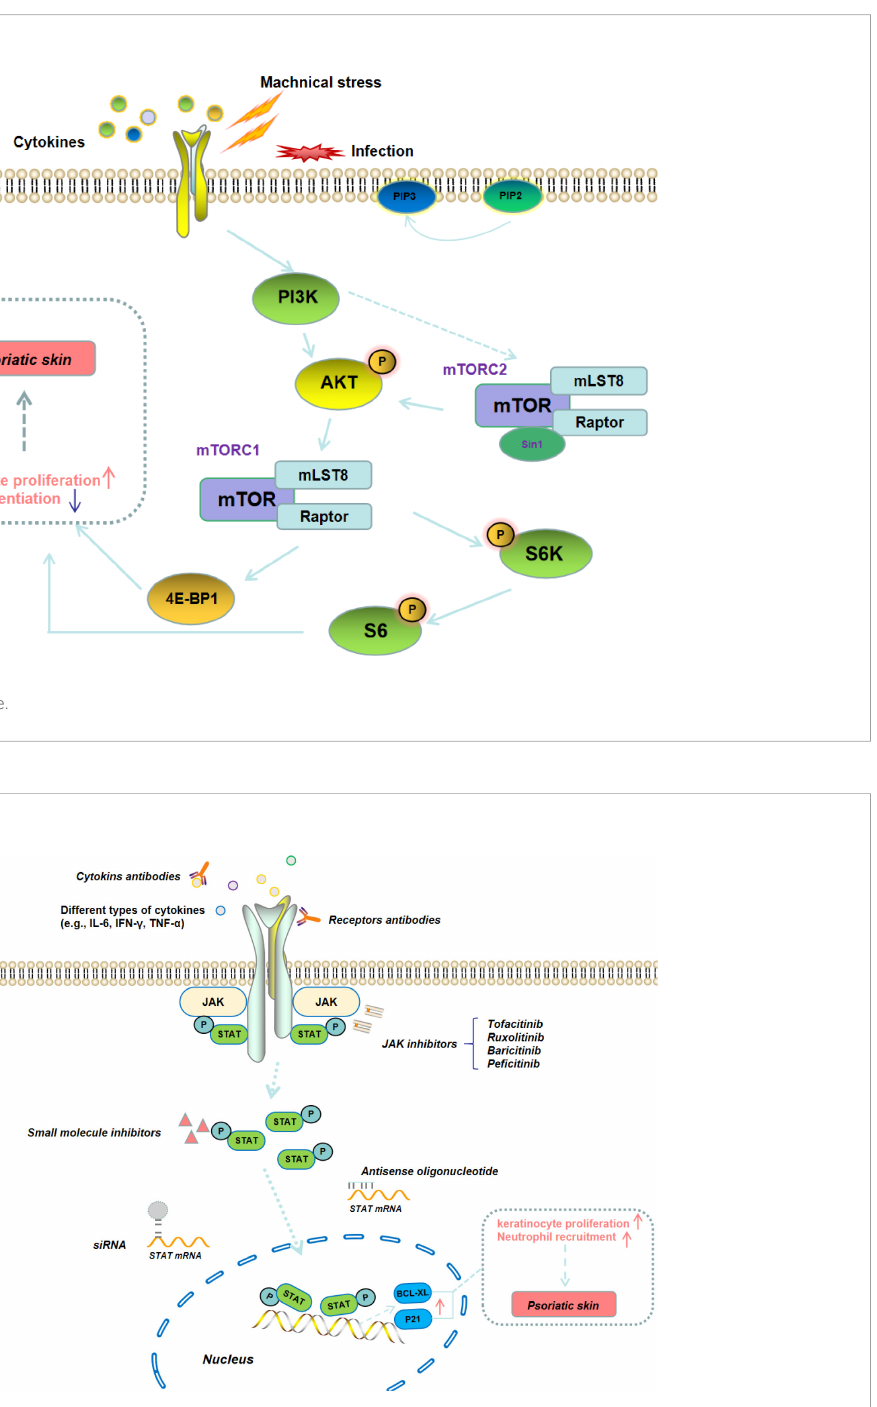
FIGURE 3 Schematic illustration of JAK/STAT signaling pathway and the corresponding therapeutic modalities for the blockage of this signaling pathway.